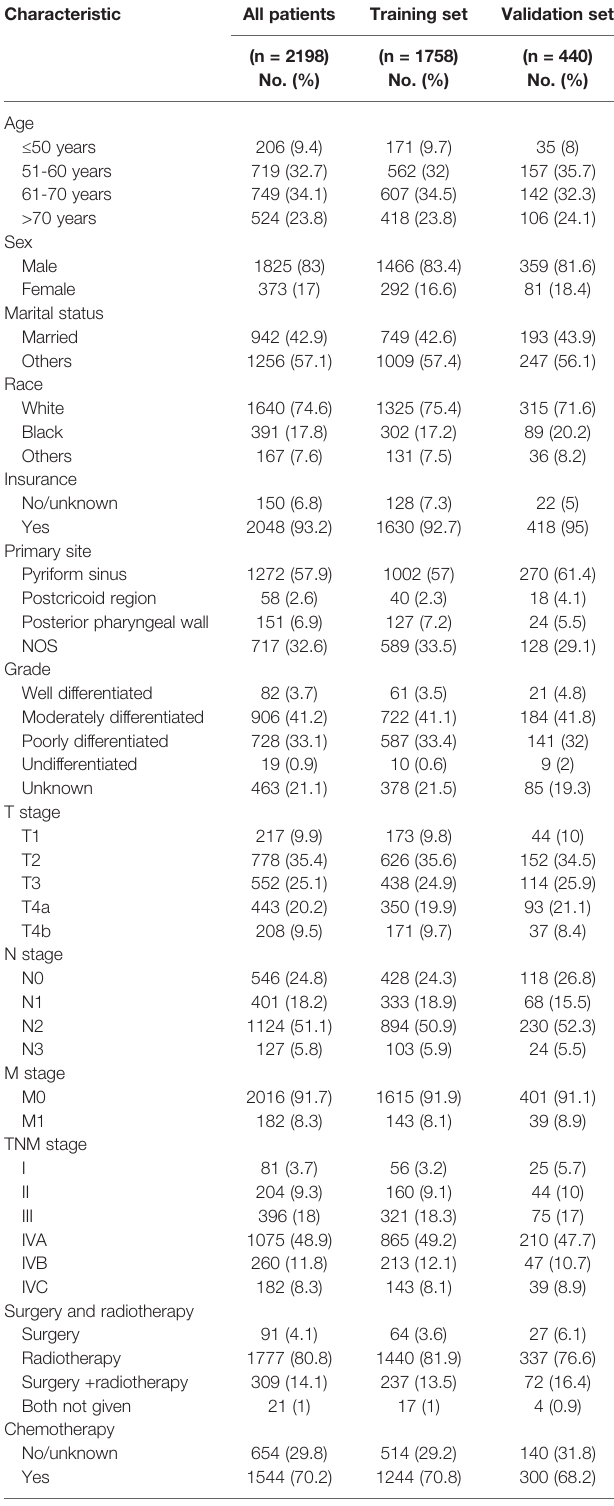
TABLE 1 | Demographics and clinical characteristics of the HSCC training and validation sets from the SEER database.